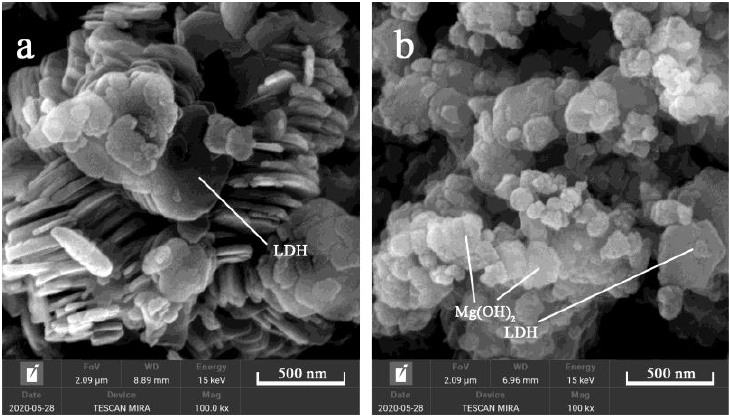
Figure 2. SEM images of Mg 2 Al-CO 3 LDHs prepared with ( a ) CO 2 and ( b ) noneascarbon sources.